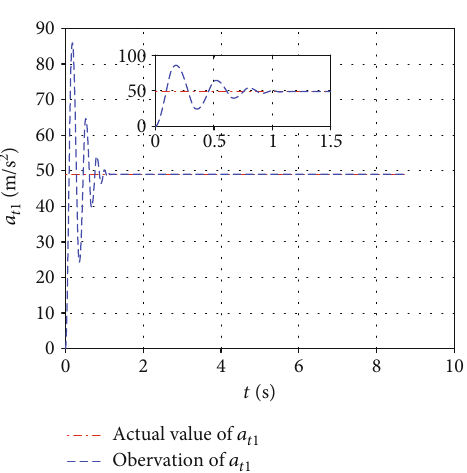
Figure 39: Target acceleration estimation in the pitch